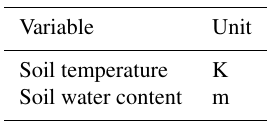
Table 4. COSMO-CLM sub-surface parameters (with units) at archived by ICHEC at 1h intervals.